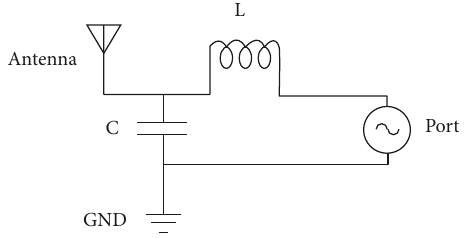
Figure 5: The equivalent circuit of the proposed